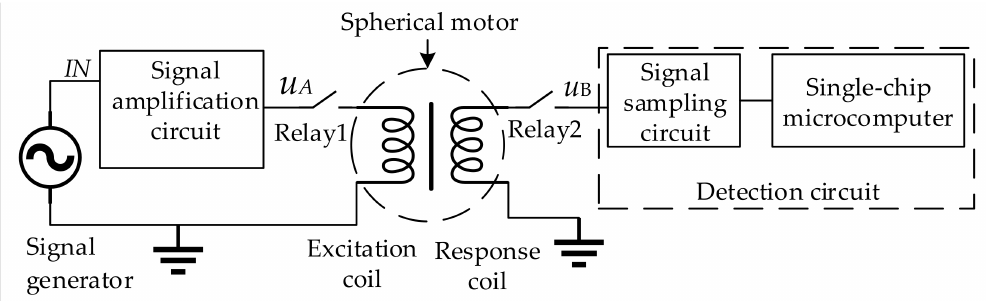
Figure 4. The block diagram of the experimental